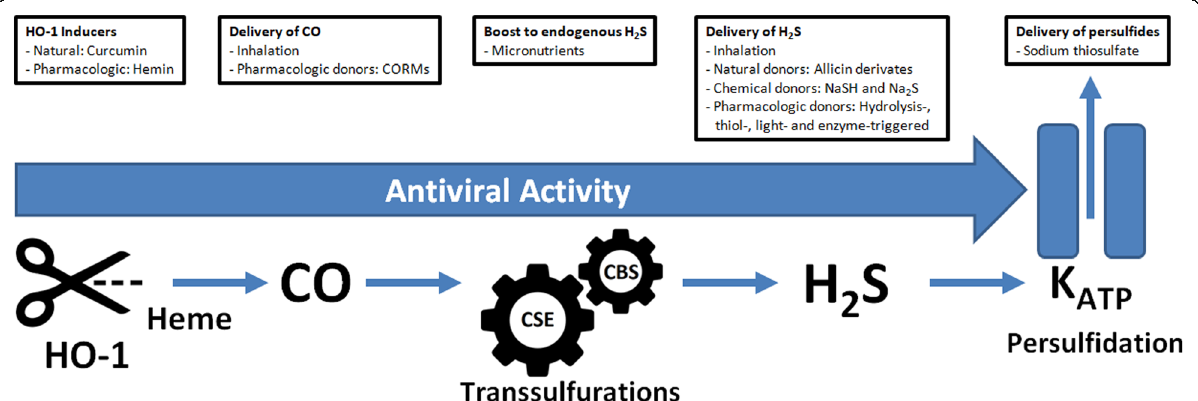
Fig. 3 Possible interventions to boost the HO-1/CO/H2S axis. The HO-1/CO/H 2 S axis can be modulated at various steps. HO-1 inducers may increase the expression and activity of the enzyme resulting in faster activation of CO release; CO delivery may compensate a defective delivery from HO-1 reactions; A boost to the endogenous H 2 S synthesis would compensate a defective activation of the alternative pathways of CBS and CSE; Direct delivery of